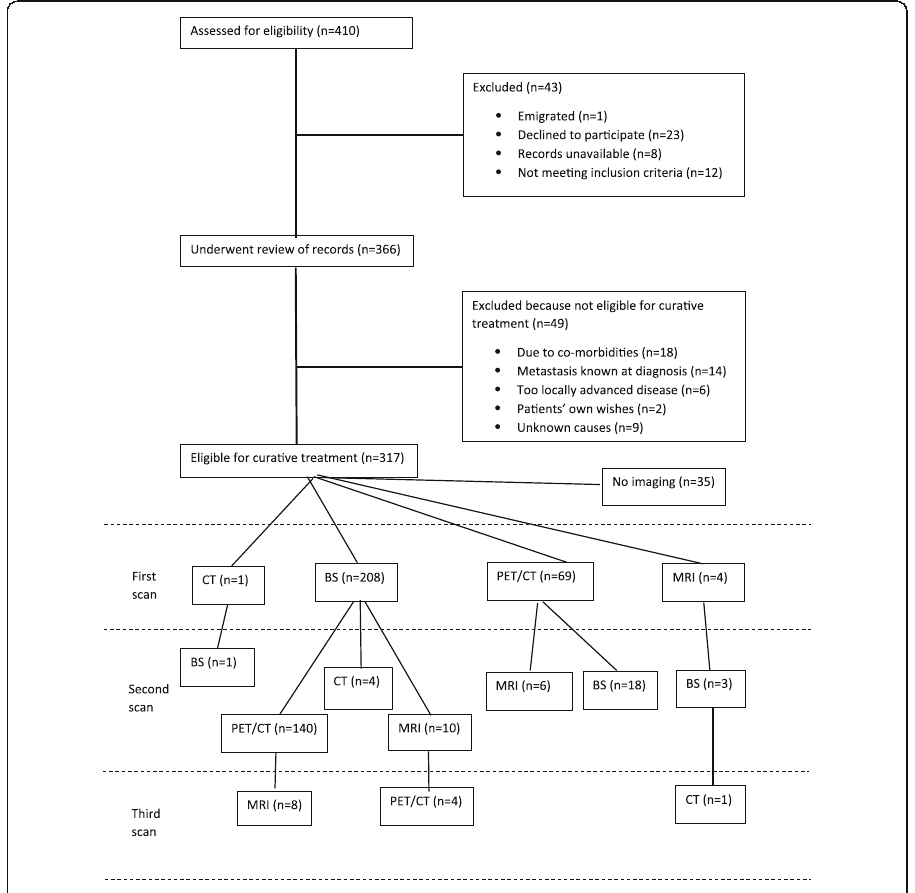
Fig. 1 Flow chart of all patients in the study. Abbreviations: CT, computed tomography; BS, bone scan; PET/ CT, positron emission tomography fused with computed tomography; MRI, magnetic resonance